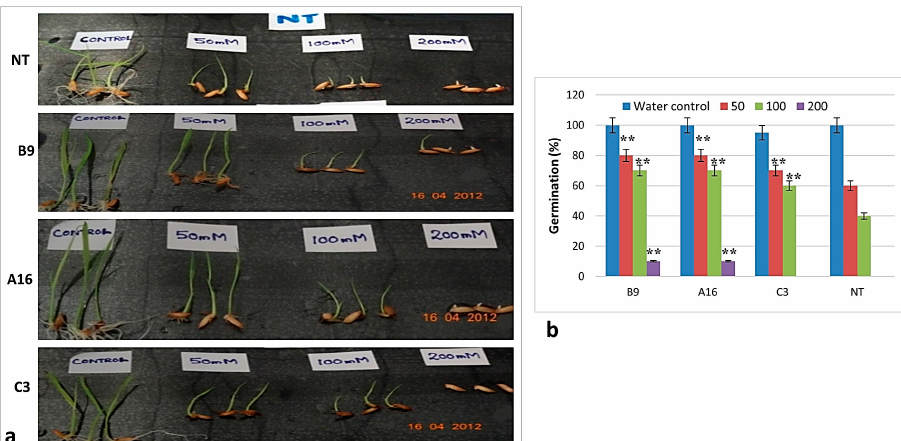
Figure 5. Evaluation of transgenic and non-transgenic ADT 43 lines (T 1 ) for their ability to germinate under 50, 100, and 200 mM NaCl stress; ( a ) Phenotype of transgenic and non-transgenic ADT 43 seedlings germinated at different concentration of NaCl; ( b ) Germination percentage of transgenic and non-transgenic ADT 43 (NT). Values are mean of fifteen replications and ** indicates statistical significance at p < 0.01 (ANOVA compared to non-transgenic ADT 43).